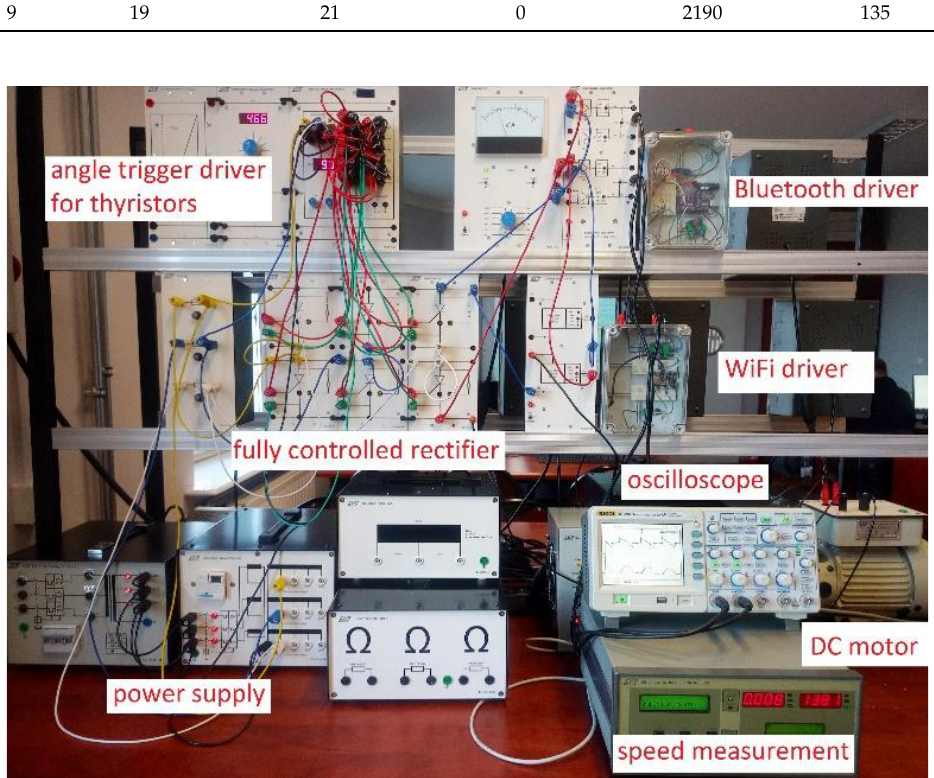
Figure 8. Laboratory stand.